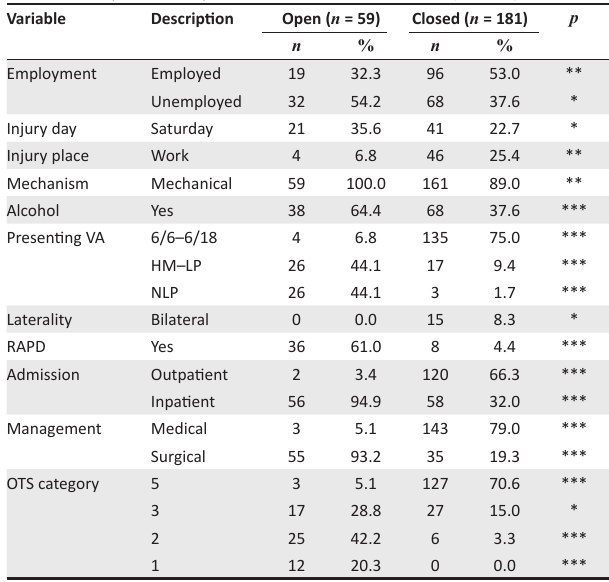
FIGURE 4: Classification of ocular trauma in all participants ( n = 240) and hospitalised participants ( n =